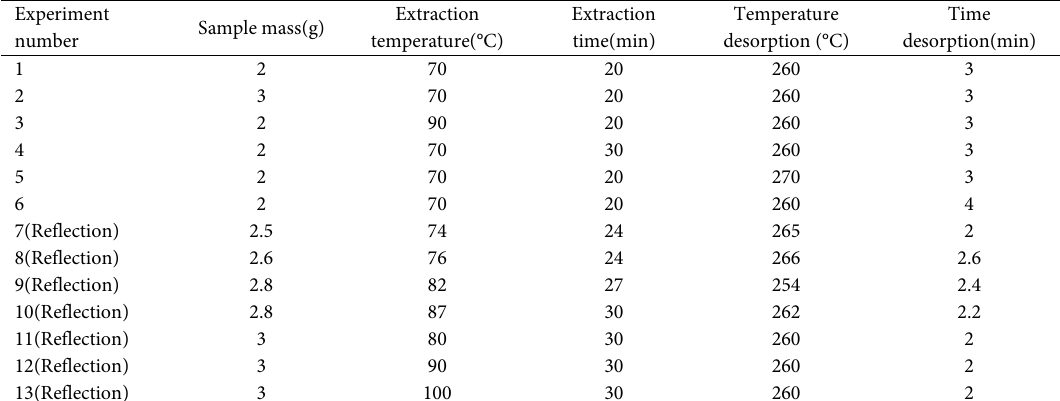
Figure 1 . The response (sum area of four main peaks of Ziziphora tenuior samples) for the designed experiments mentioned in Table 1.